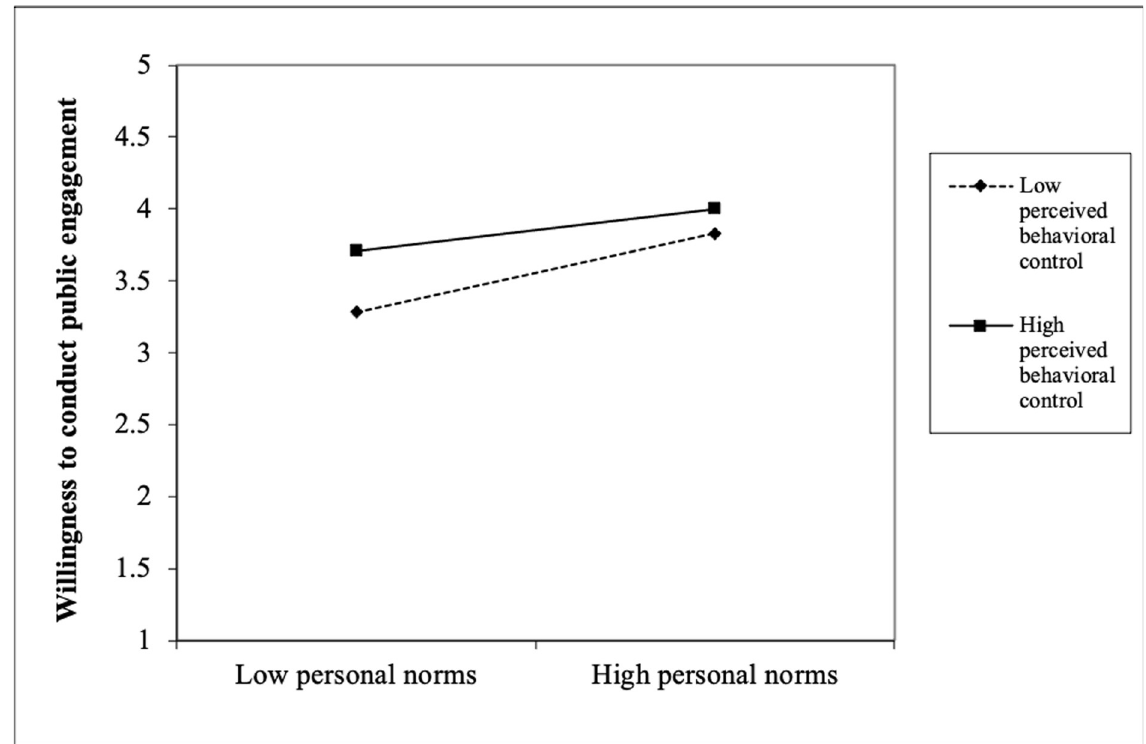
Fig 5. Perceived behavioral control as a moderator of the personal norms-willingness